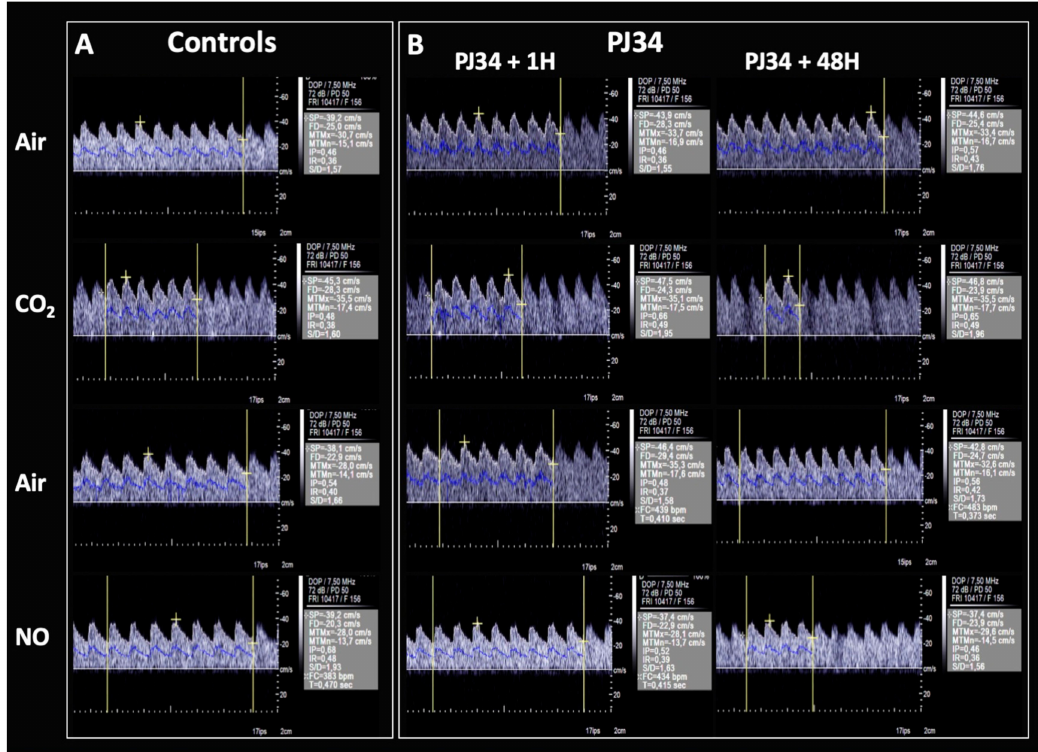
Figure 1. Representative Doppler velocity waveforms recorded in the basilar trunk (BT) in a control ( A ) and a PJ34-treated ( B ) adult mouse. Recordings were performed under light anaesthesia (isoflurane 0.5%) limiting the movement of the animal without any cardiorespiratory depression: (1) under air; (2) 3–5 min after breathing a gas mixture (CO 2 5%, O 2 16%, and N 2 79%) known to provoke